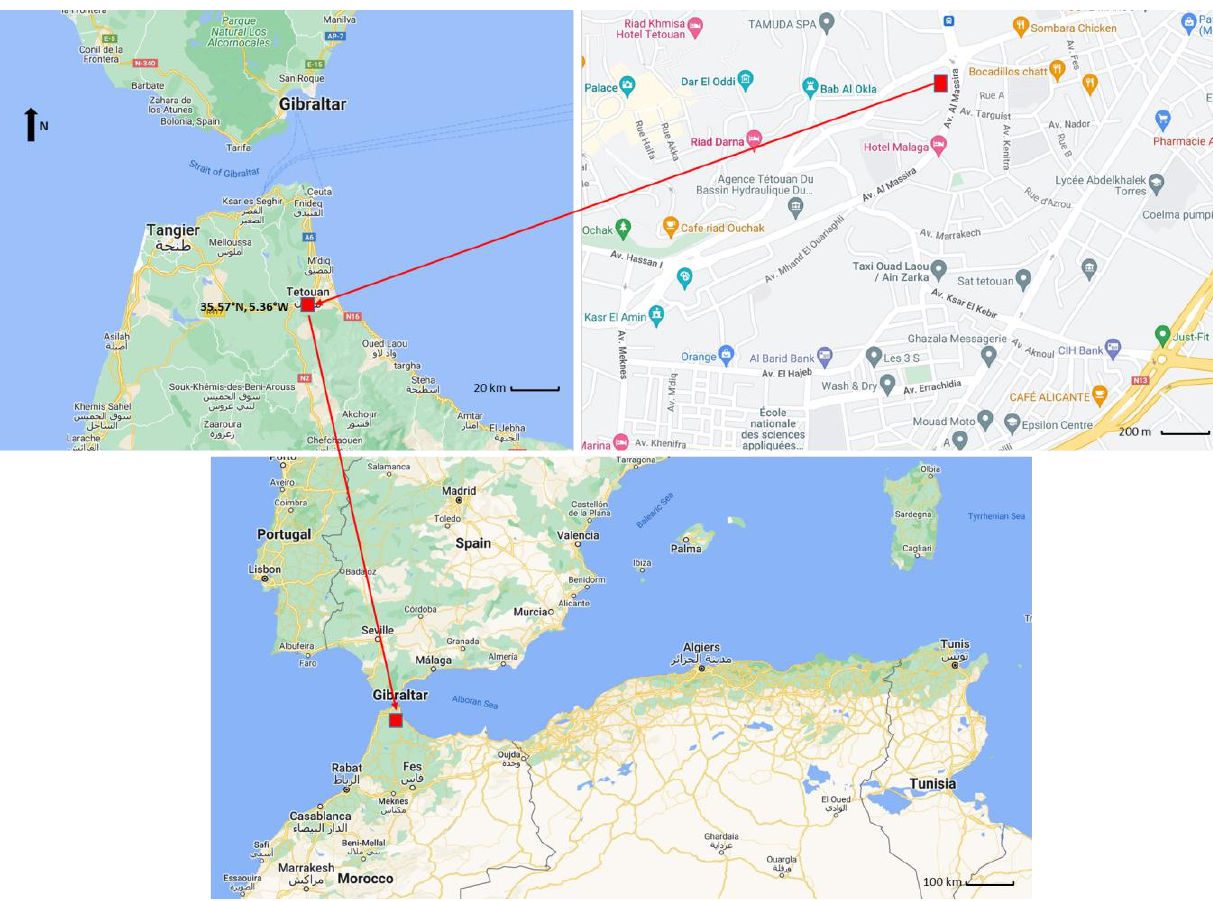
Figure 1. Sampling site (35.57° N, 5.36° W) for measurement of the atmospheric aerosols in Tetouan city (red square), located in the Mediterranean region ( bottom panel), close to the historical city center of Tetouan ( upper right panel) and in an urban area ( upper left panel). Note the different scales of the maps.